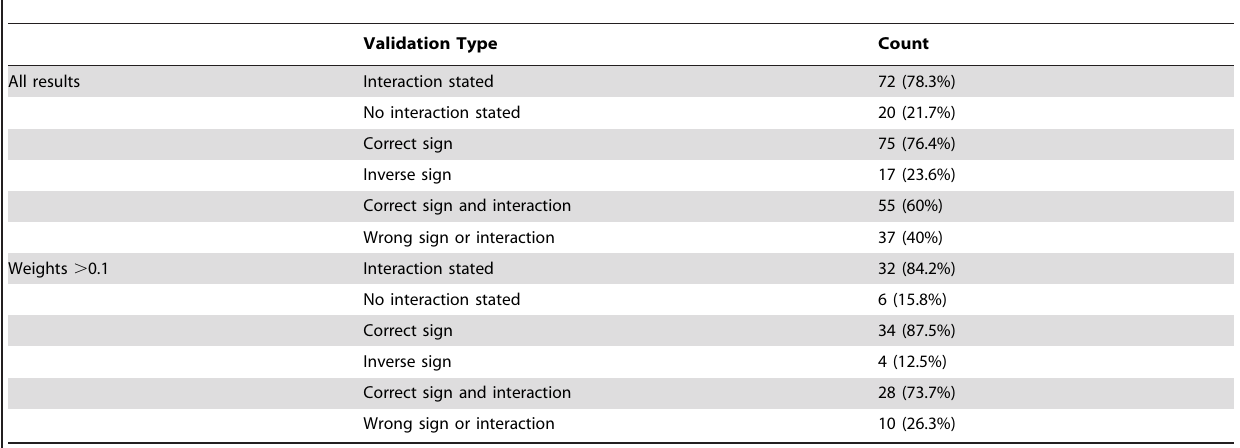
Table 5. Literature validation of newly included